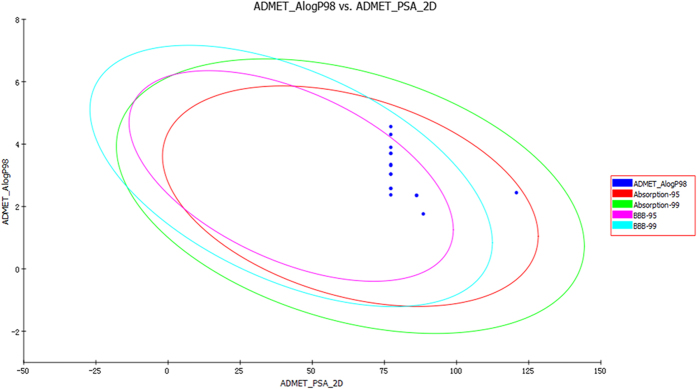
ADMET properties predicted for eighteen novel compounds.Compounds located inside the innermost oval have the best results. The eight compounds were as follows: 3m, 3r, 3f, 3p, 3c, 3d, 3e, 3i (from top to bottom, from left to right).